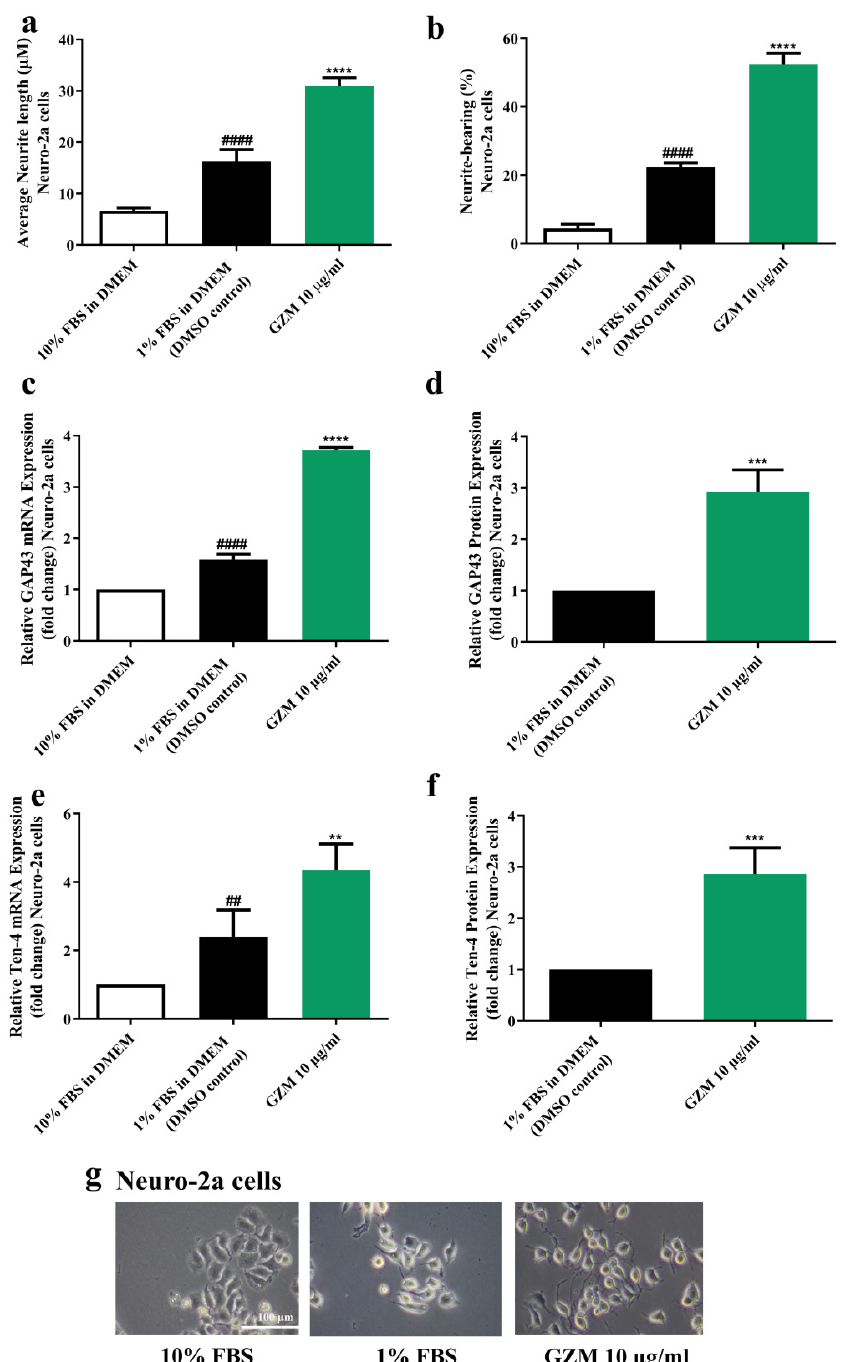
Figure 6. Effect of GZM extract on neurite outgrowth. GZM extract-treated Neuro-2a cells increased the average neurite length ( a ) and the percentage of neurite-bearing cells ( b ). The morphology of Neuro-2a cells was observed under a light microscope at 10 × magnification ( g ). GZM extract increased the expression levels of the neuron markers GAP-43 ( c , d ) and Ten-4 ( e , f ) in Neuro-2a cells. The details of statistical values are provided in Table S7 (Supplementary Materials). ( n = 3; ** p < 0.01, *** p < 0.001, and **** p < 0.0001 1% FBS (DMEM) control vs. GZM extract treatment; ## p < 0.001 and #### p < 0.0001 10% FBS (DMEM) vs. 1% FBS (DMEM). To further ensure the occurrence of neurite outgrowth activities, the expression of the neurite outgrowth markers, growth-associated protein 43 (GAP-43) [19], and Teneurin-4 (Ten-4) [20] were determined. GZM extract significantly upregulated GAP-43 and